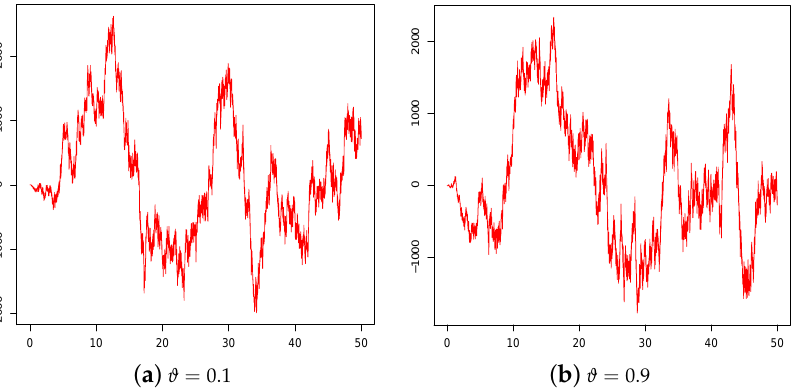
Figure 7. Simulated sample paths of the process Y ( t ) obtained via (75), where R ( t k − 1 , t k ) is given in (76) with α = − 0.2, β = 1.5 and σ 2 =